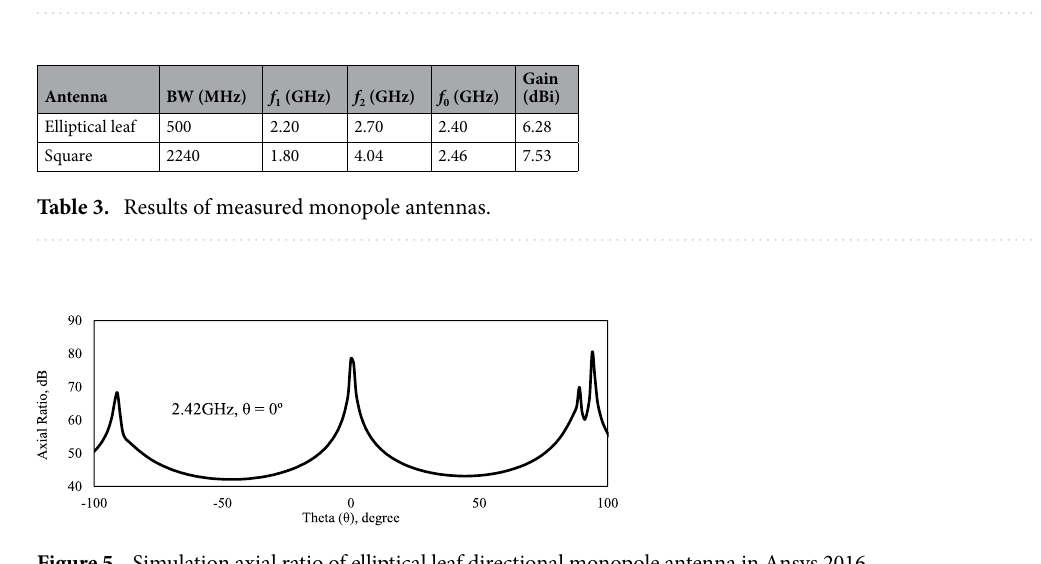
Figure 4. Comparison of measured results of square and elliptical leaf directional monopole antenna.